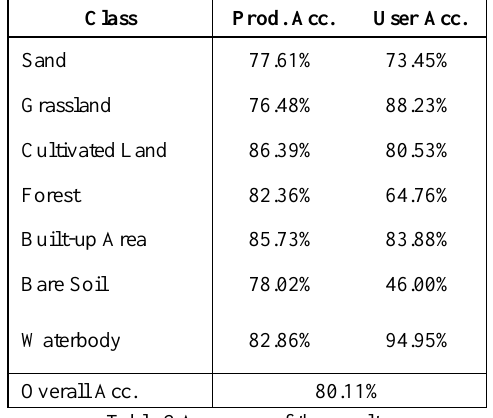
Table.2 Accuracy of the results